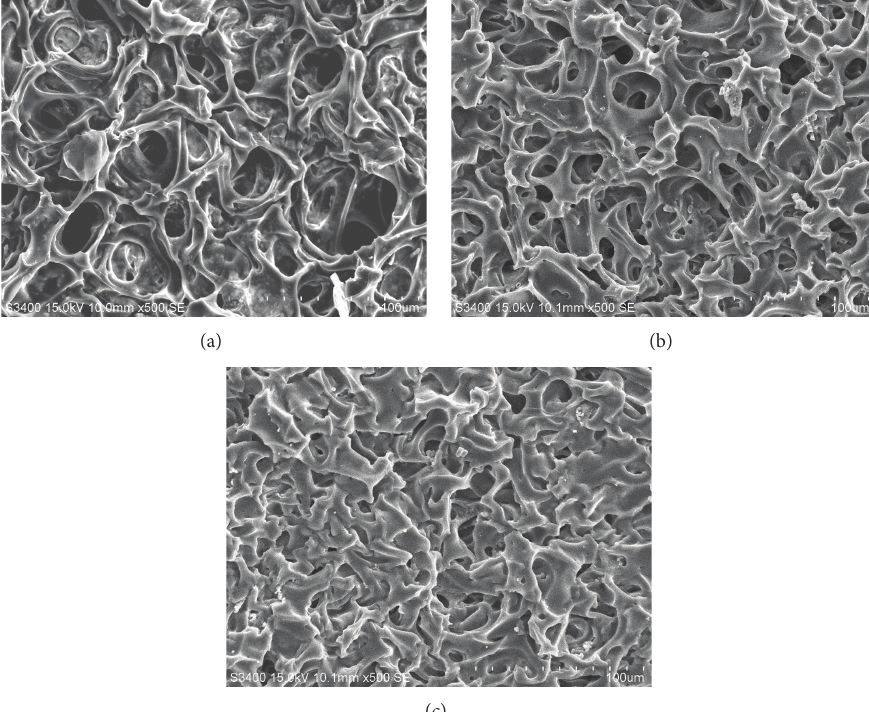
Figure 6: SEM image of degraded PVA-g-chitosan 3D scaffolds (CH50) by enzyme ((a) original material, (b) lipase, and (c)